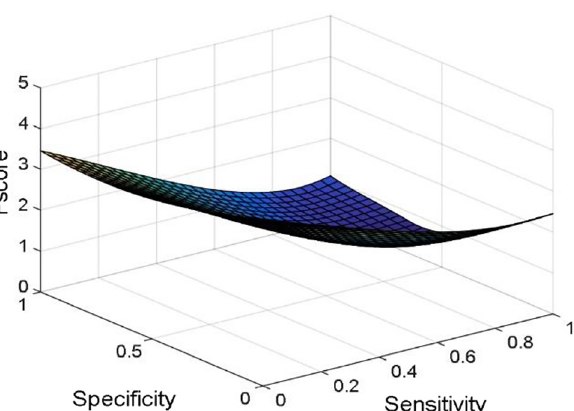
Figure 22: Sensitivity versus specificity versus F-score